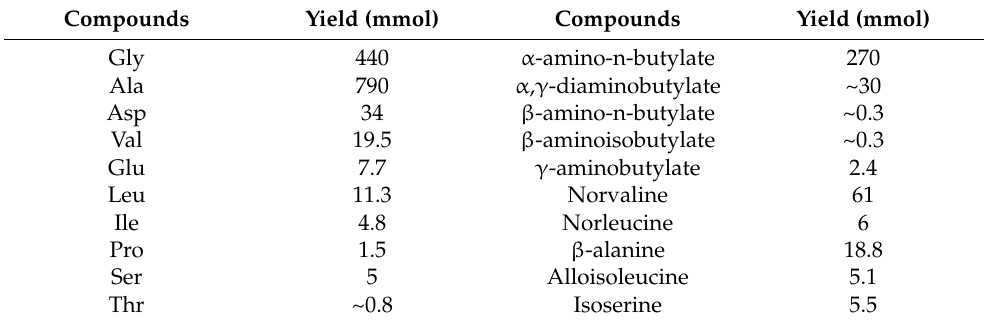
Table 1. Experimental results obtained by Miller [10]. The results indicate that various natu- ral and nonnatural amino acids should be produced with prebiotic means and accumulated on primitive Earth. Yield